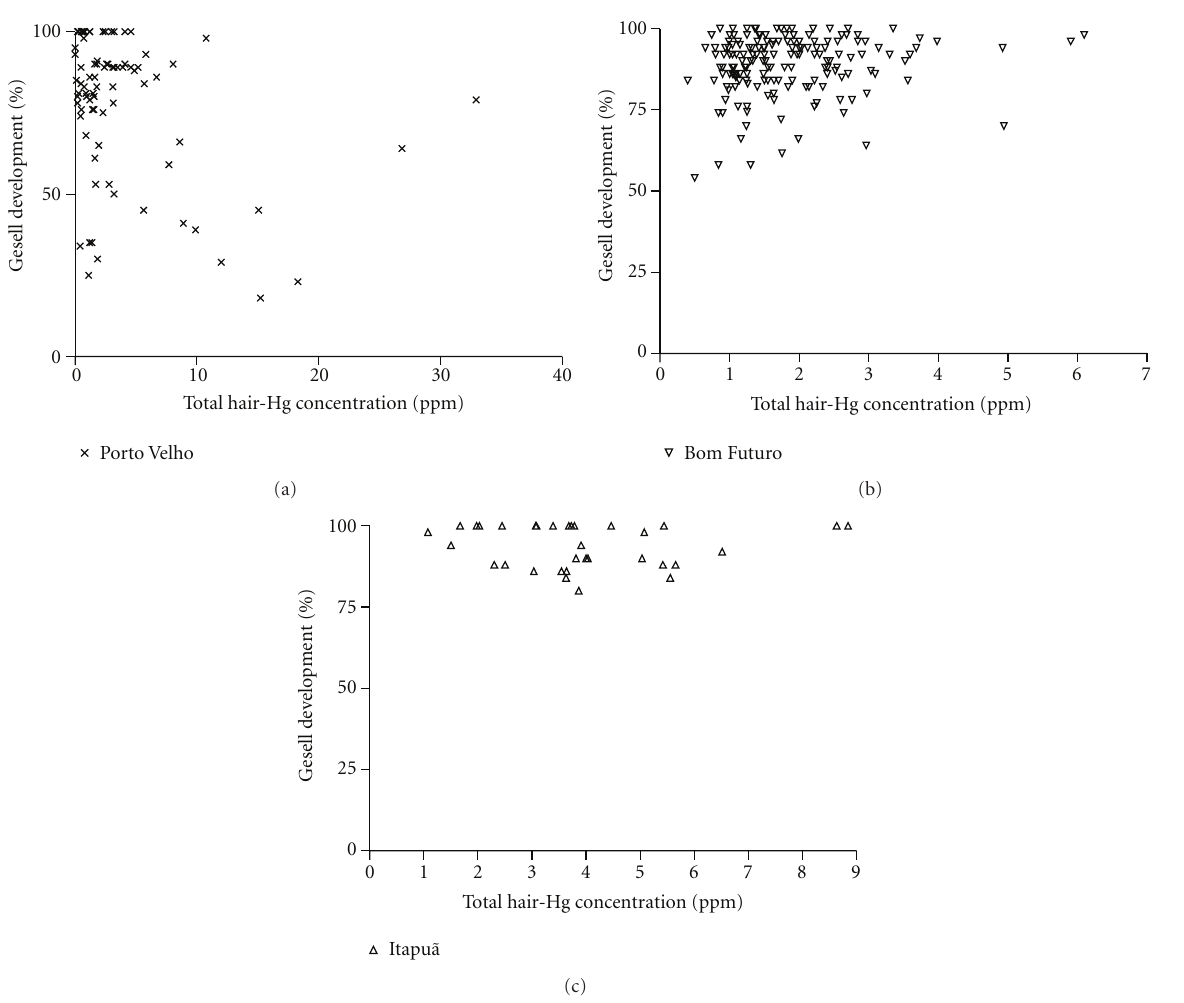
Figure 5: Scatter plots of total hair-Hg concentrations and Gesell development scores in the 3 settings of tested